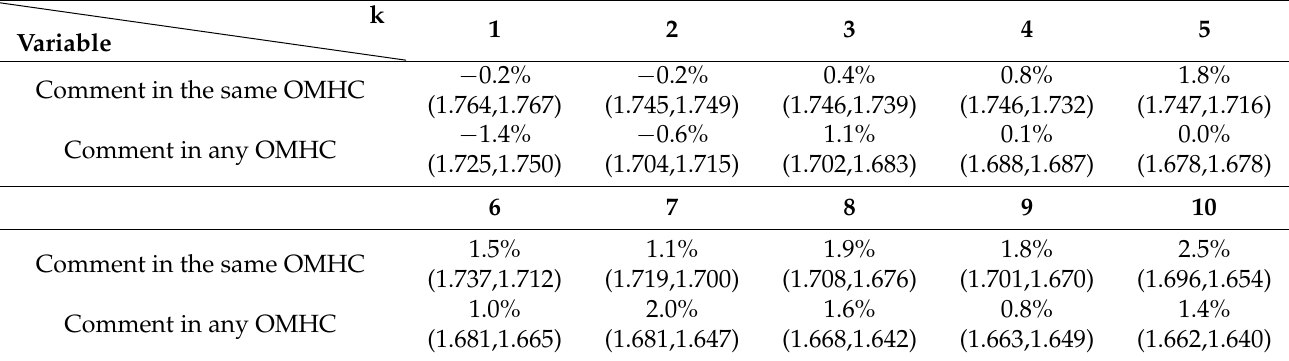
Table 3. The difference in the empathy level of users’ subsequent k comments between “comment group”(left) and “no comment group”(right), and their respective values.